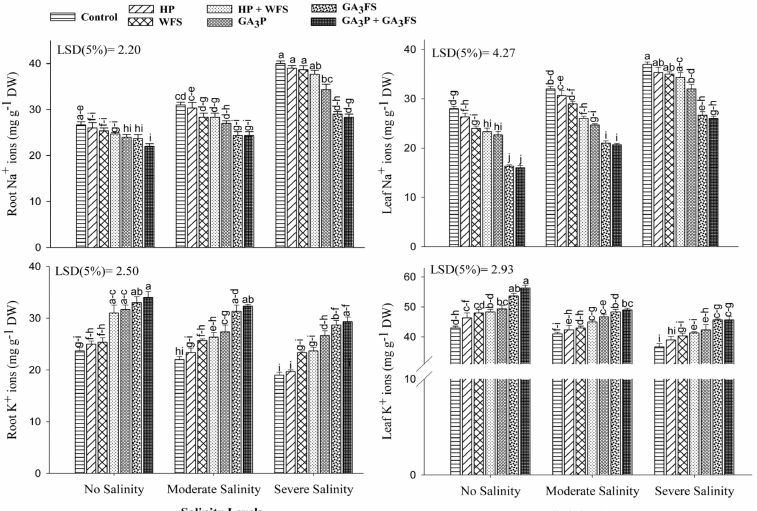
Figure 8. Sodium (Na + ) and potassium (K + ) ion concentration in different maize parts as affected by different treatments of gibberellic acid under no salinity (control), moderate salinity (6 dS m − 1 ), and severe salinity (12 dS m − 1 ). Values are means ± SD (n = 3). Hydropriming (HP); water foliar spray (WFS); hydropriming and water foliar spray (HP + WFS); seed priming with GA 3 (GA 3 P); foliar spray with GA 3 (GA 3 FS); seed priming and foliar spray of GA 3 (GA 3 P + GA 3 FS). Bars with the same letters do not differ significantly at p ≤ 0.05.